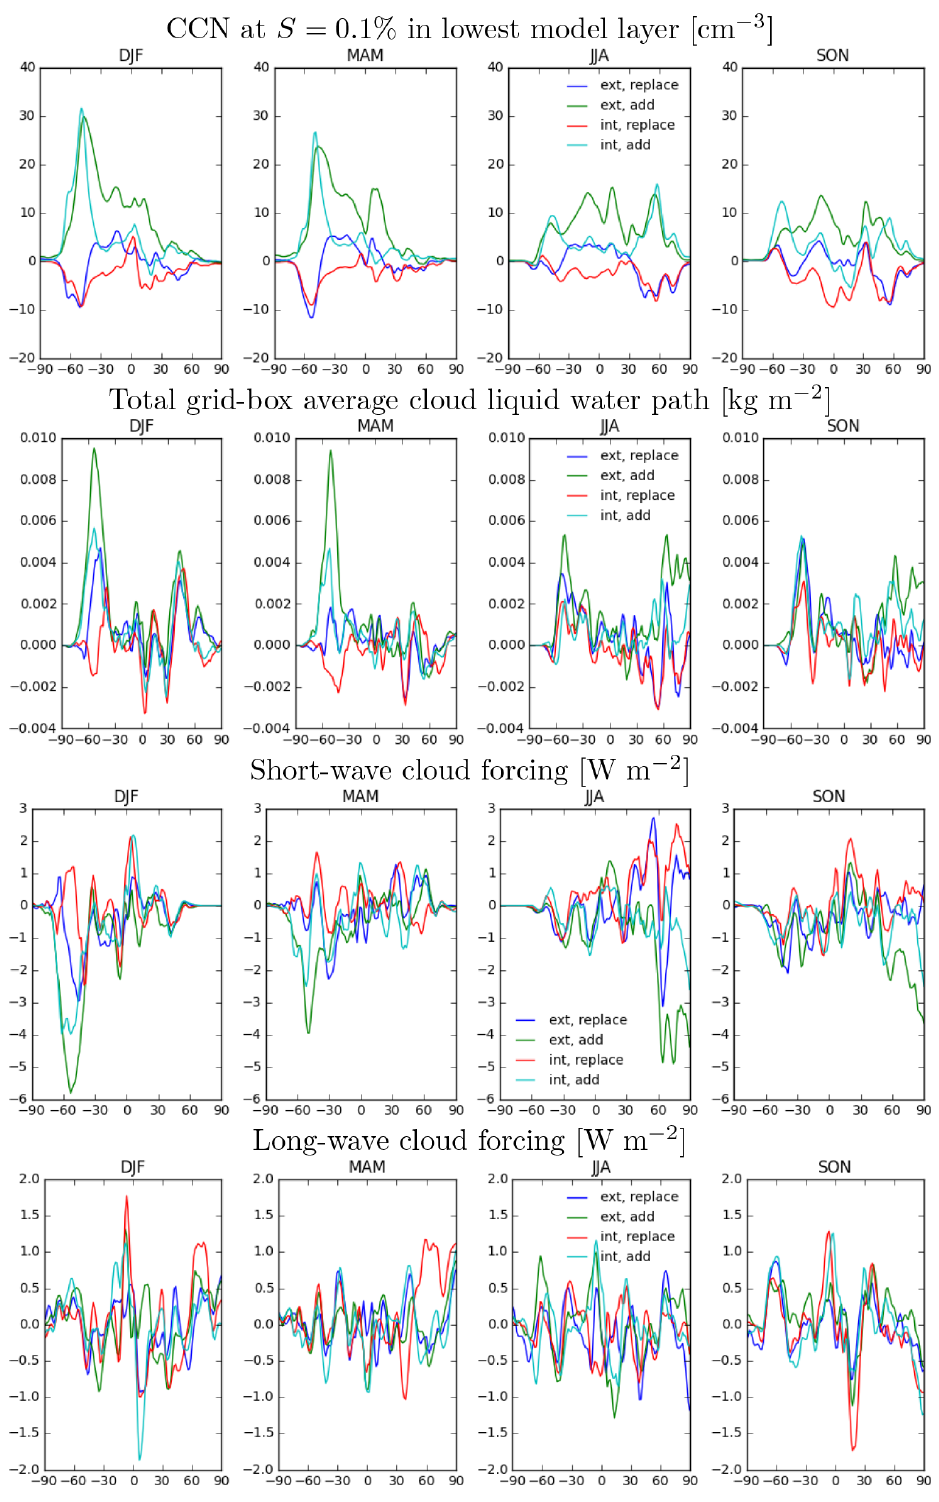
Figure 8. Difference in zonal mean for marine organics cases, relative to control simulation, by season. Top: CCN at S = 0 . 1% in the lowest model layer (cm − 3 ). Second row: total grid-box average cloud liquid water path (kg m − 2 ). Third row: short-wave cloud forcing (W m − 2 ). Fourth row: long-wave cloud forcing (W m − 2